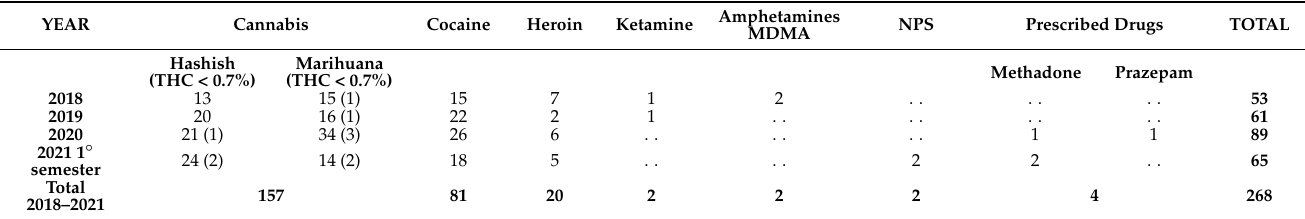
Table 1. The illicit drugs detected from seizures in Naples (Italy) from January 2018 to June 2021. Cannabis Cocaine Heroin Ketamine